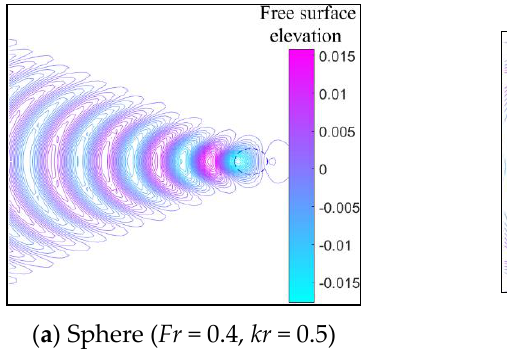
Figure 7. Real part of diffraction wave contour of ( a ) submerged sphere and ( b ) Wigley I ship.